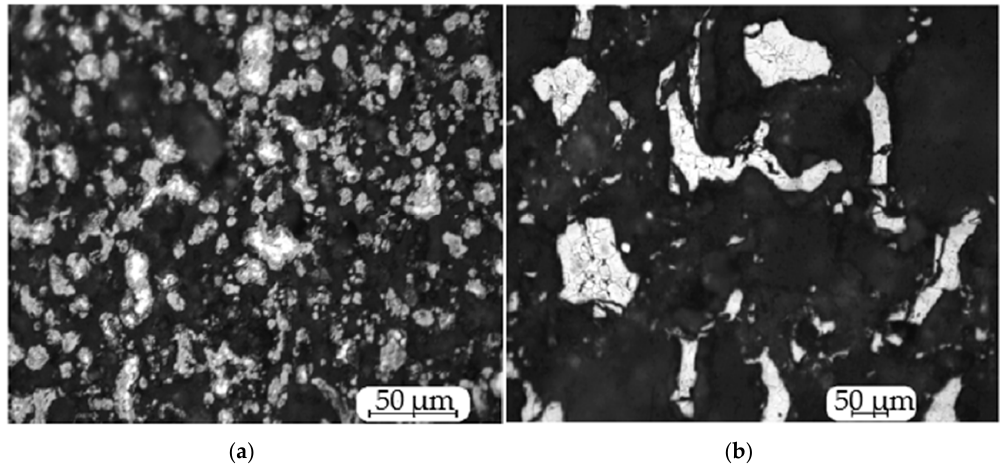
Figure 8. Microstructure of chromium sample at combustion in natural ( a ) and forced ( b ) filtration mode.